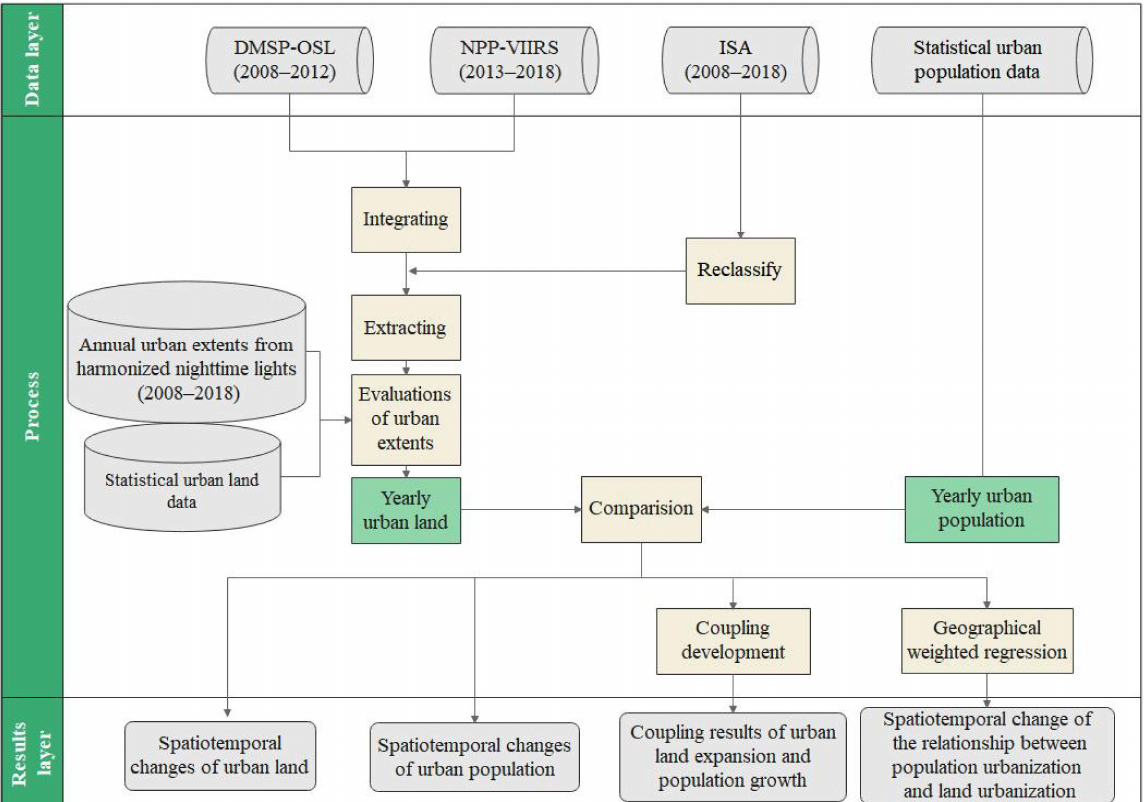
Figure 2. Flowchart and technical framework of the research.